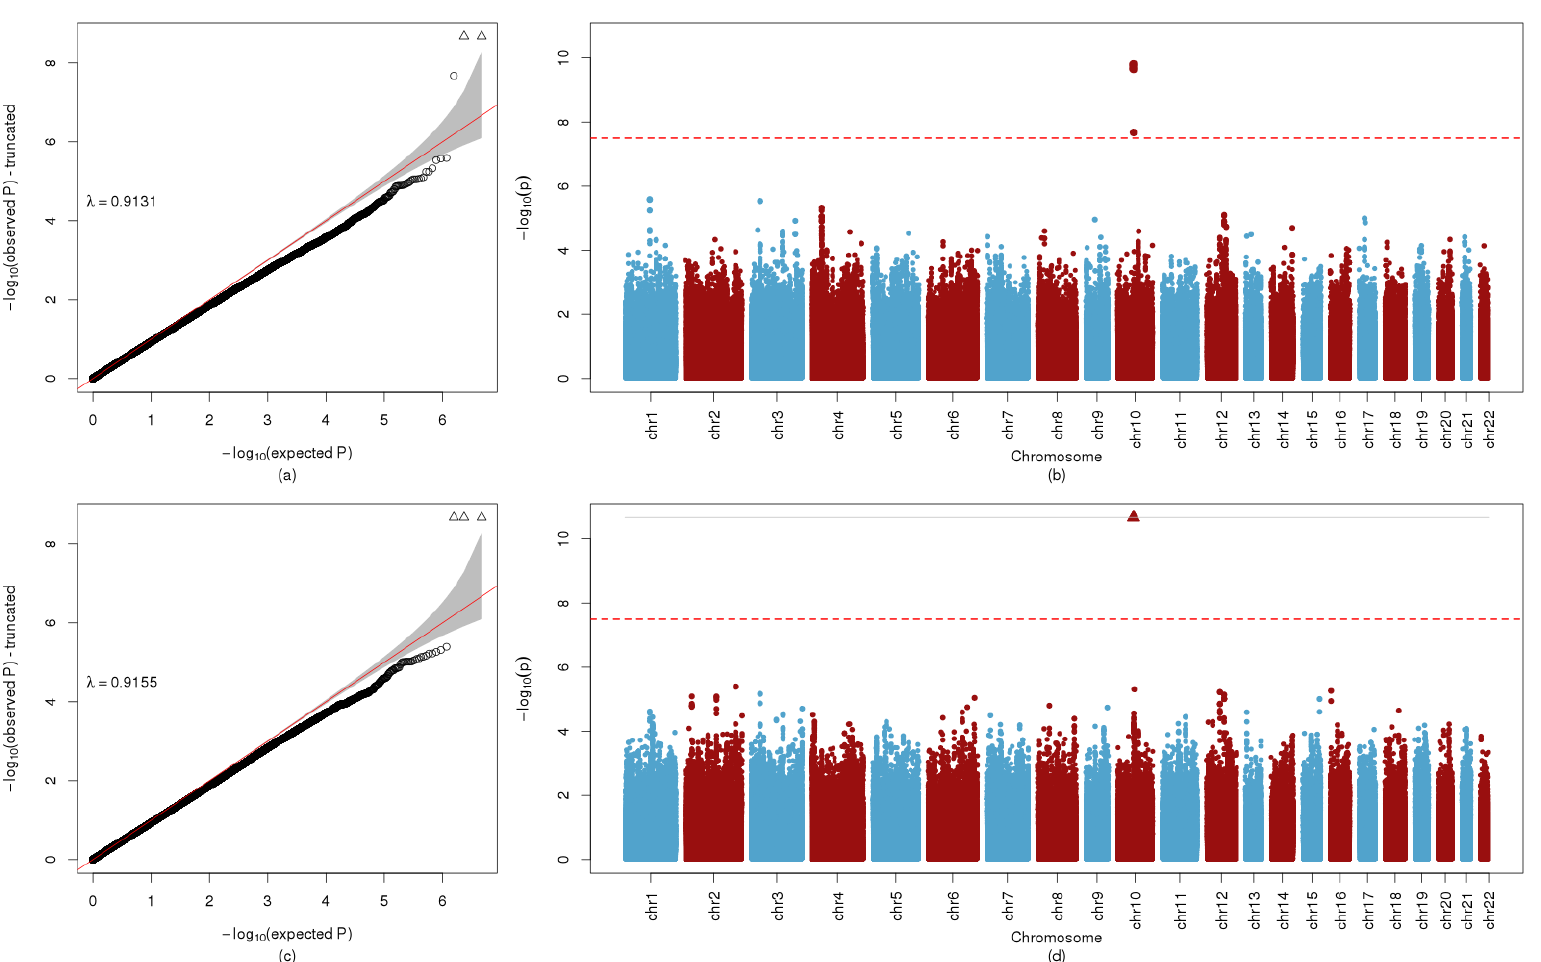
Figure 1. QQ and Manhattan Plot AC C2. ( a ) QQ plot of GWA with fasting AC C2, with corresponding genomic inflation factor, λ . ( b ) Manhattan plot of GWA with fasting AC C2. The red line indicates -log 10 p = 7.5, the criterion used for potential inclusion in the BNM. ( c ) QQ plot of GWA with 1-hr AC C2, with corresponding genomic inflation factor, λ . ( d ) Manhattan plot of GWA with 1-hr AC C2. The red line indicates − log 10 p = 7.5, the criterion used for potential inclusion in the BNM.